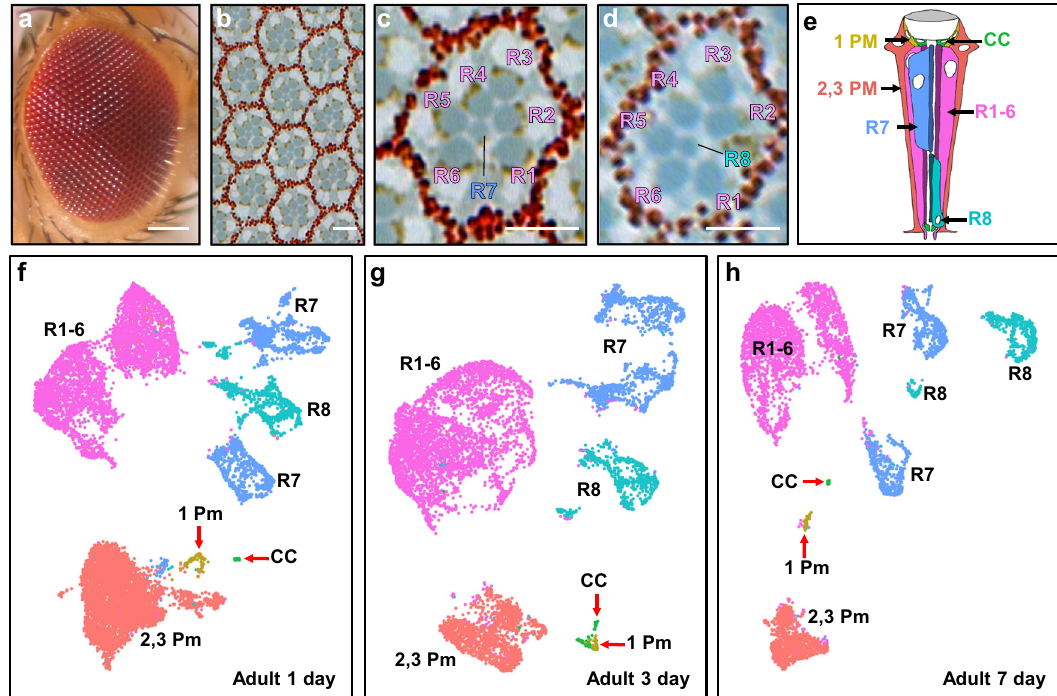
Fig. 1 Single-cell RNA sequencing of adult Drosophila eyes reveals all expected cell types. a External image of an adult eye; scale bar: 100 µ m. b Tangential section of an adult eye shows about 10 ommatidia; scale bar: 5 µ m. c , d High magni fi cation views of tangential sections of an ommatidium at the R7 ( c ) and R8 ( d ) focal planes. Scale bars: 5 µ m. e Schematic of the different cell types present in an adult ommatidium; there are six R1-6 cells in each ommatidium but only two are shown in this view. Reproduced/adapted with permission from Fig. 1b in Rister et al., 2013, Development 86